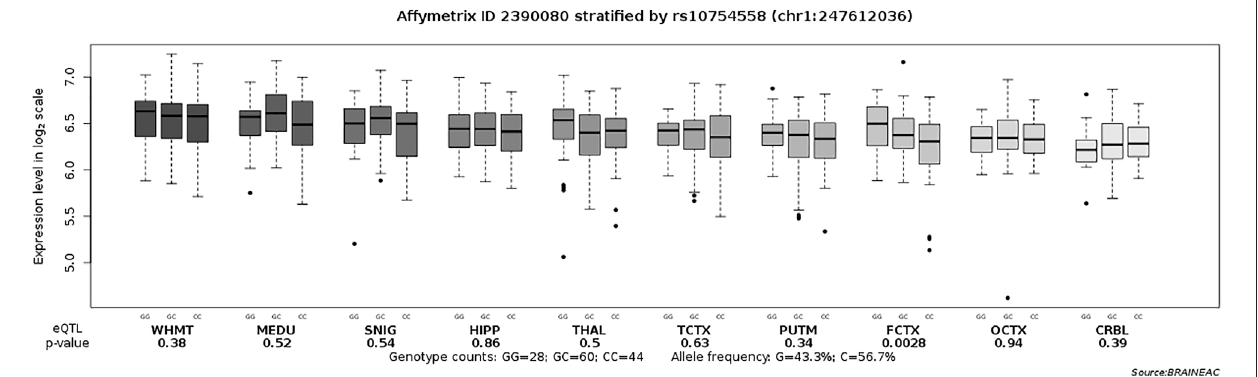
FIGURE2| Associationofrs10754558polymorphismwiththe NLRP3 mRNAexpressionlevelintenbrainregions(AffymetrixID2390080).SNIG,substantianigra; PUTM, putamen (at the level of the anterior commissure); MEDU, the inferior olivary nucleus (sub-dissected from the medulla); THAL, thalamus (at the level of the lateral geniculate nucleus); OCTX, occipital cortex; HIPP, hippocampus; FCTX, frontal cortex; TCTX, temporal cortex; WHMT, intralobular white matter; CRBL, cerebellar cortex. Data were extracted from the BRAINEAC database